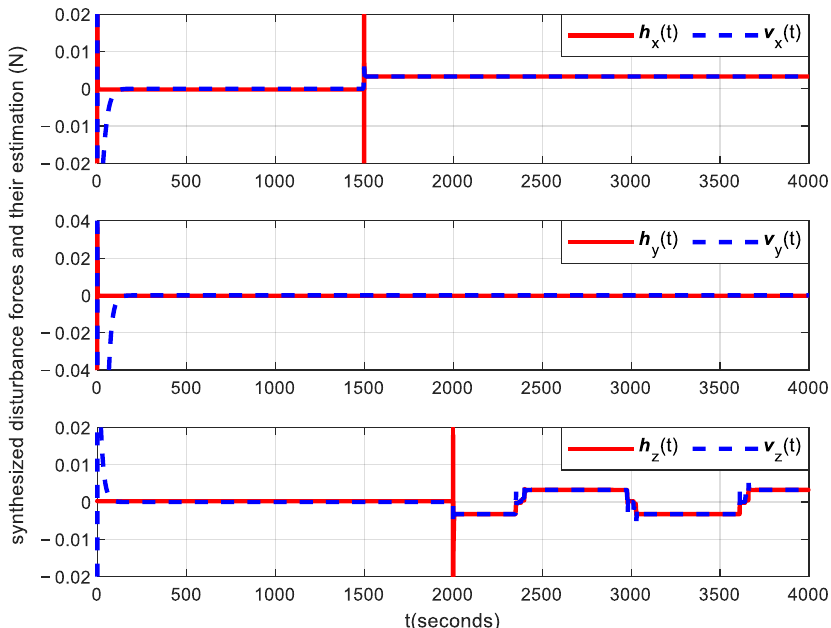
Figure 9. Three-dimensional tracking trajectory for spacecraft formation configuration maintenance.